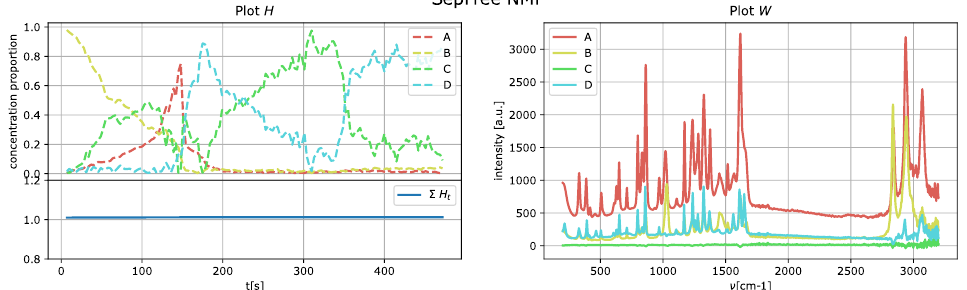
Figure 9. SepFree NMF analysis of the crystallization Raman spectrum with r = 4. Minimal memory effect is det ( S ) = 0.031.